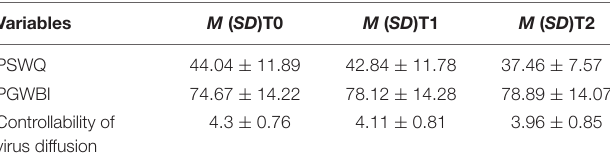
TABLE 2 | Difference between evaluation times in levels of worry, psychological well-being and controllability of COVID-19 diffusion.